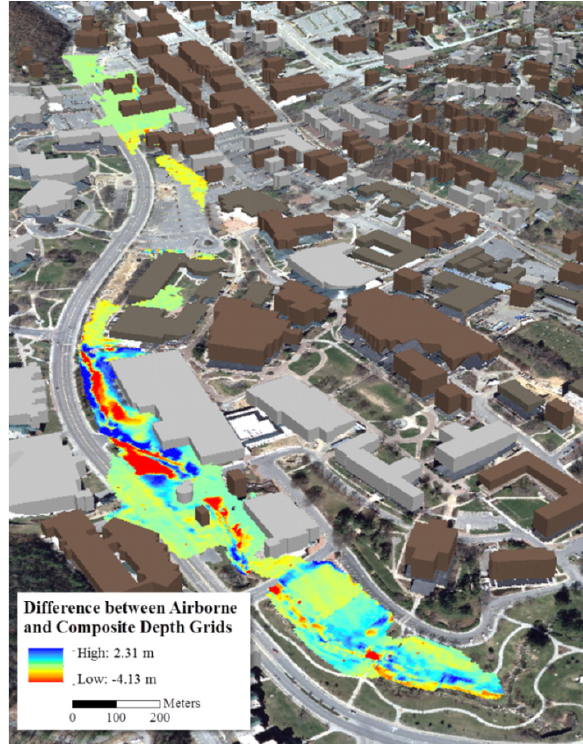
Figure 11. Difference between the depth grids generated using the bare-earth airborne LiDAR data and bare-earth composite LiDAR data, derived by subtracting the composite depth grid from the airborne depth grid. Areas containing dark blue represent locations where the airborne depth grid was greater than the composite depth grid. Areas containing red indicate locations where the composite depth grid was greater than the airborne depth